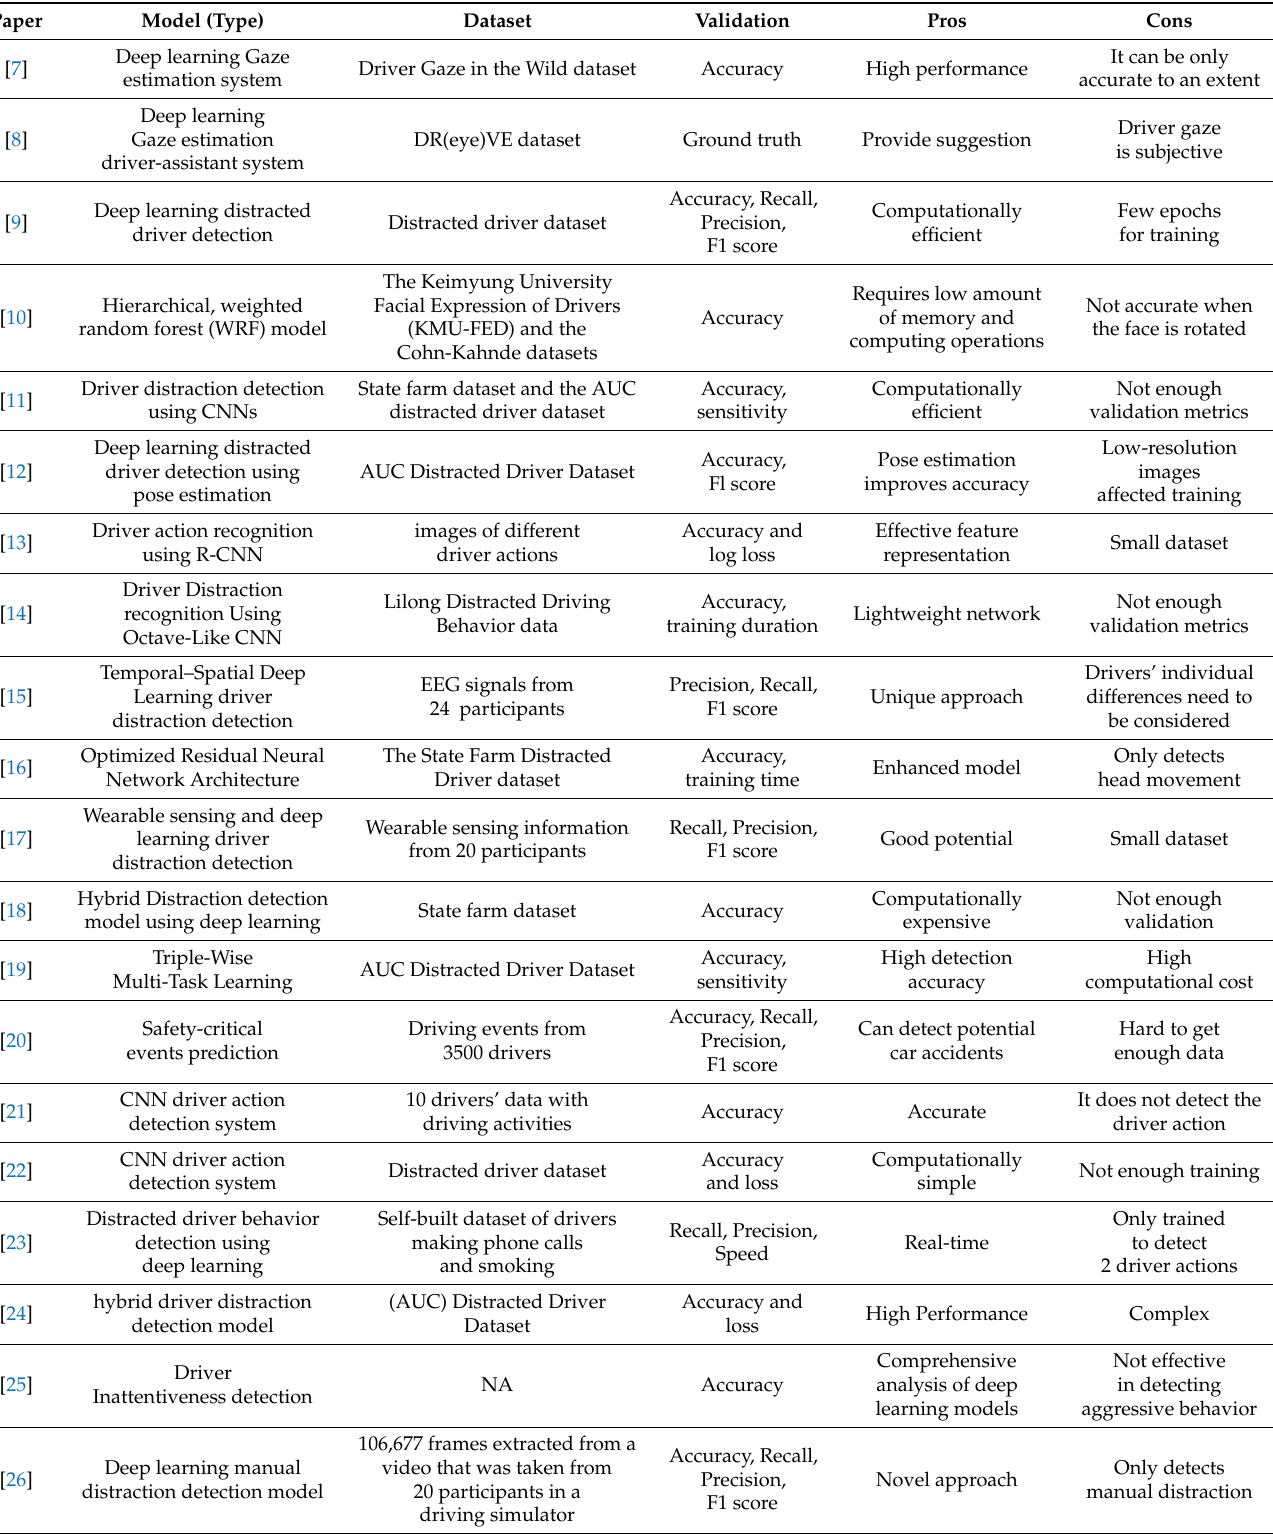
Table 1. Comparative Analysis of Driver Distraction detection